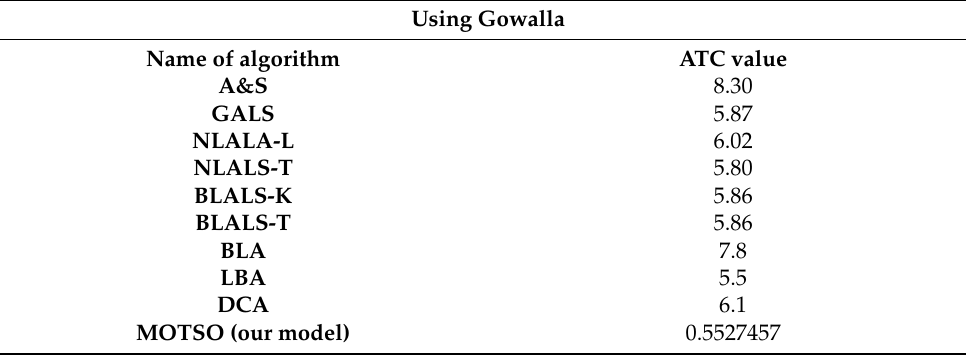
Table 11. The results of the average travel cost ( ATC ) using different algorithms.